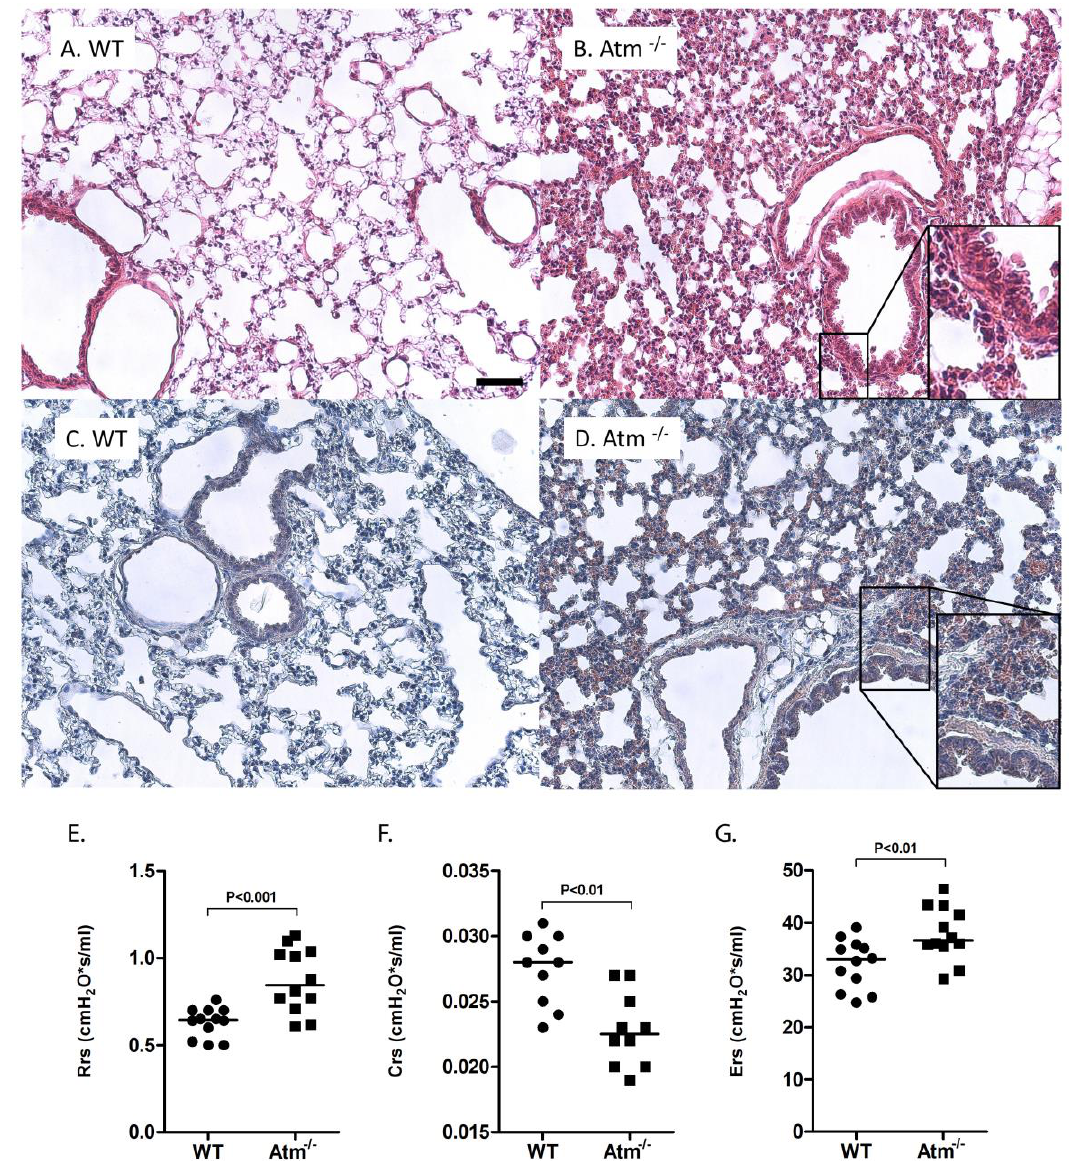
Figure 1. Lung injury in Atm -deficient mice. Representative histological lung sections of ( A , C ) wild-type (WT) and ( B , D ) Atm -deficient (Atm − / − ) mice stained with hematoxylin and eosin ( A , B ) or with chloracetate esterase staining ( C , D ), respectively. Lung function testing using a FlexiVent mouse ventilator, respiratory system resistance ( E ), compliance ( F ), and elastance ( G ) in Atm − / − mice compared to a WT control group ( n = 10–12). Bar = 100 µm.